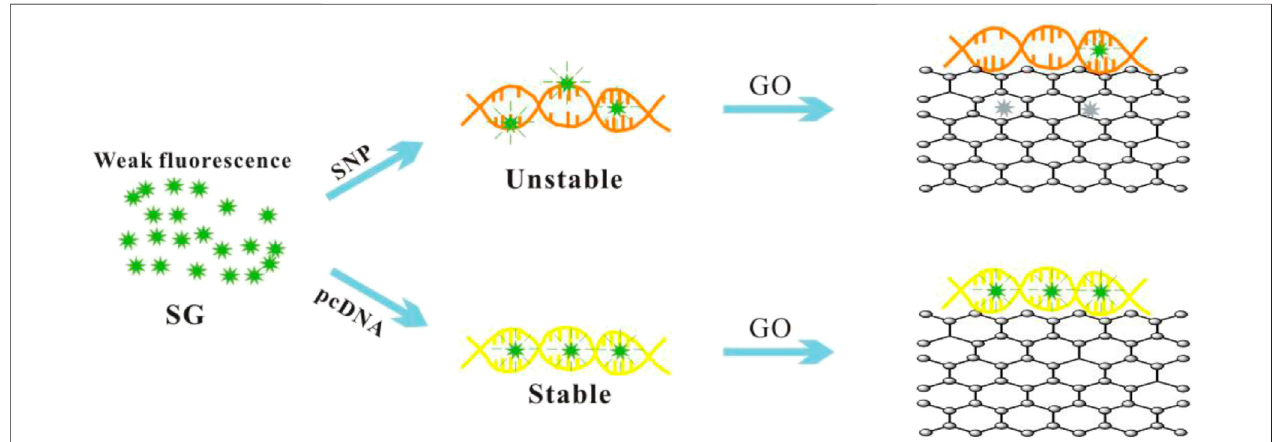
SCHEME 1 | SNP assay sensor composed of graphene oxide (GO) and SYBR Green I (SG)